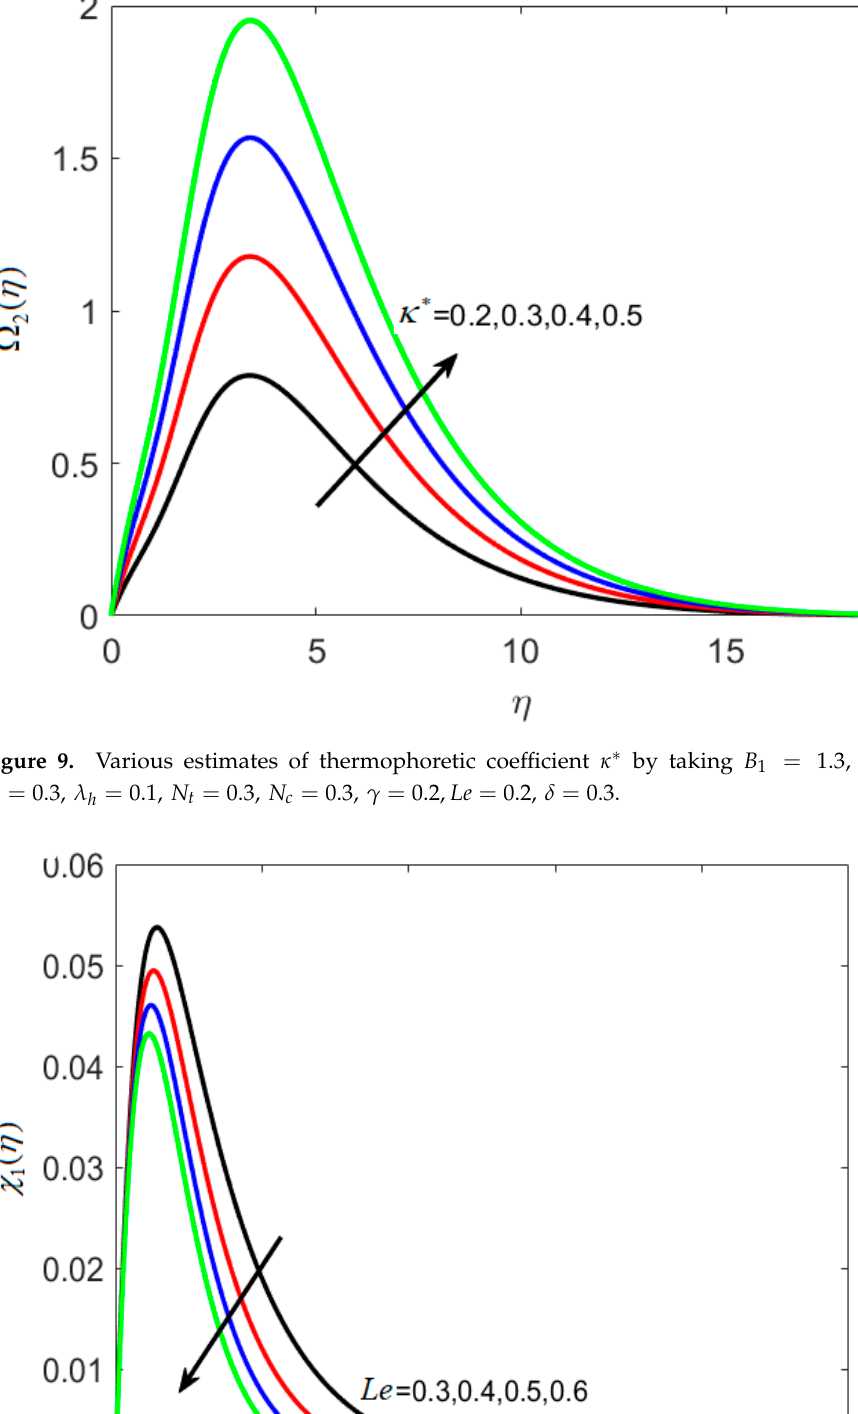
Figure 10. Various estimates of Lewis number Le by taking B 1 = 1.3, B 2 = 1.2, S t = 0.3, λ h = 0.1, N t = 0.3, N c = 0.3, κ ∗ = 0.1, γ = 0.2, δ =